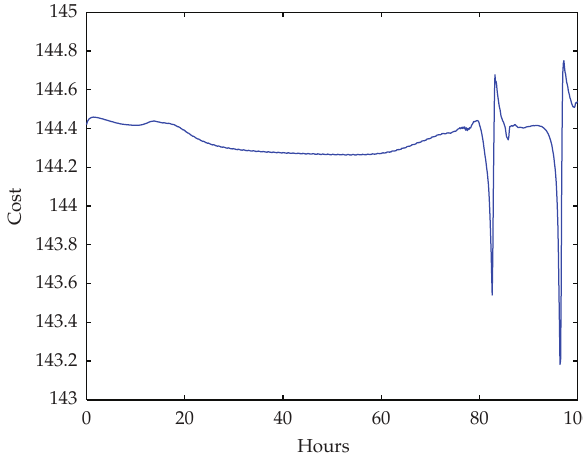
Figure 6: The optimal value of the cost of both the